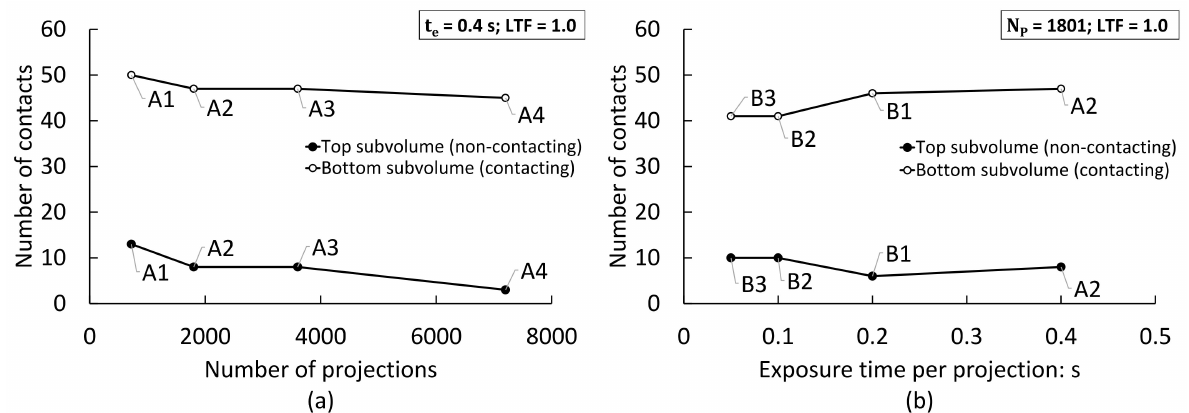
Figure 5. Number of contacts found in XCT data with (top subvolume) and without (bottom subvolume) a prescribed interparticle separation: ( a ) with different number of projections and using a constant exposure time per projection (t e = 0.4 s); ( b ) with different exposure time per projection and using a constant number of projections (N P = 1801) per 180 ◦ rotation. Data labels refer to scan identifiers; see Table